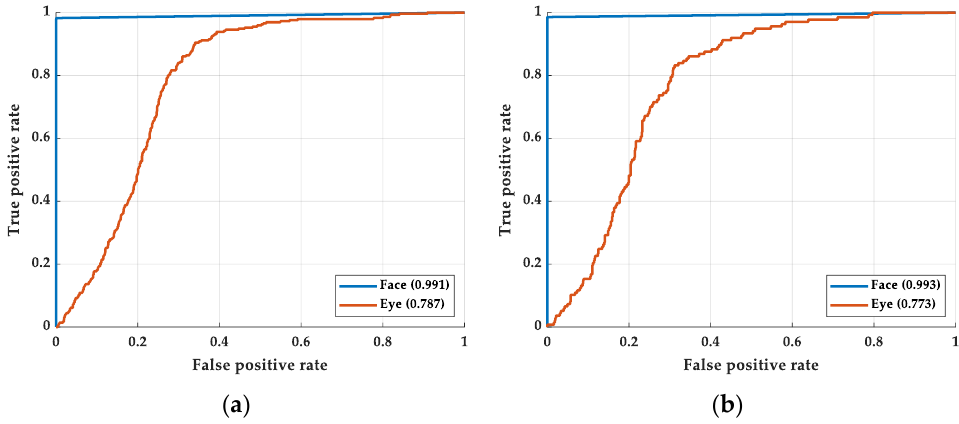
Figure 11. The ROC curve of the gender classification: ( a ) training process and ( b ) testing process.